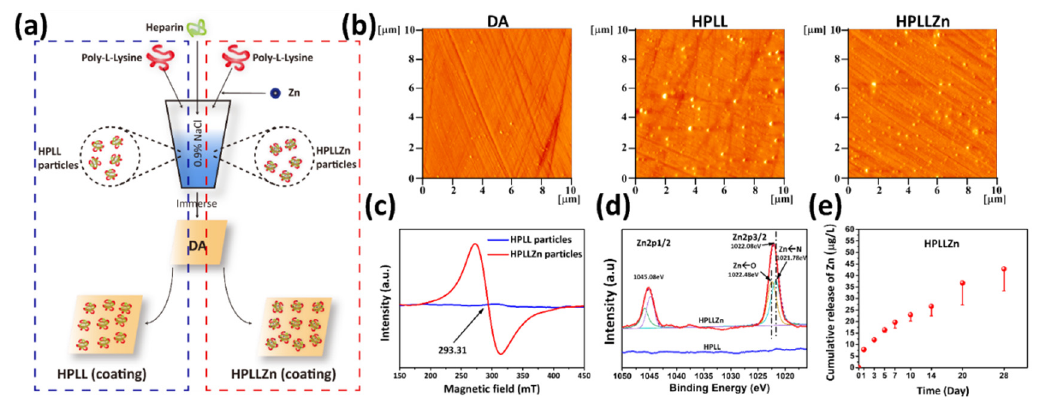
Figure 3. ( a ) Schematic illustration of the preparation of HPLL and HPLLZn. ( b ) AFM images of DA, HPLL, and HPLLZn. ( c ) The EPR spectra of HPLLZn particles used for coating preparation. ( d ) Zn 2p XPS spectrum of coatings. ( e ) Quantitative characterization of Zn leaching from HPLLZn (DA, dopamine coating; HPLL, heparin/poly-L-lysine coating; HPLLZn, heparin/poly-L-lysine/Zn coating).